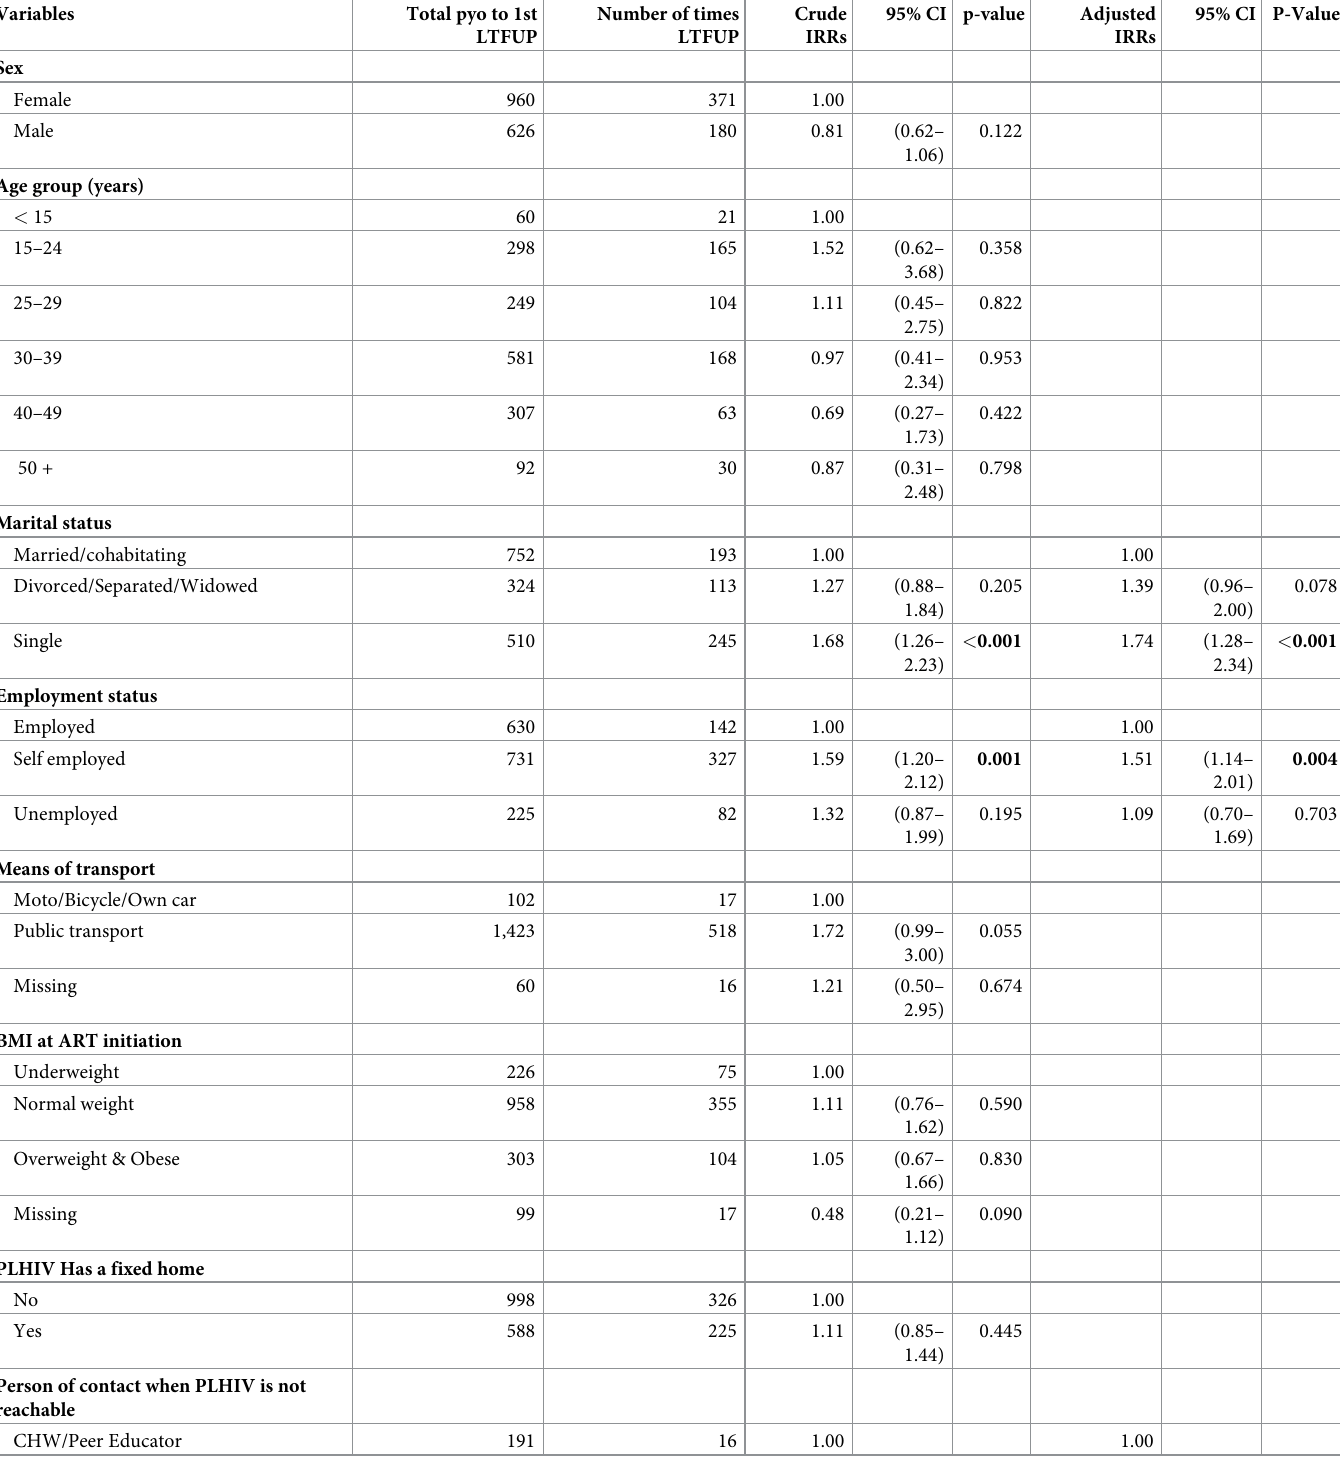
Table 3. Generalized estimating equations analyzing repeated measurement outcomes of LTFUP and associated factors among PLHIV who initiated ART in 2018, Nyarugenge district,